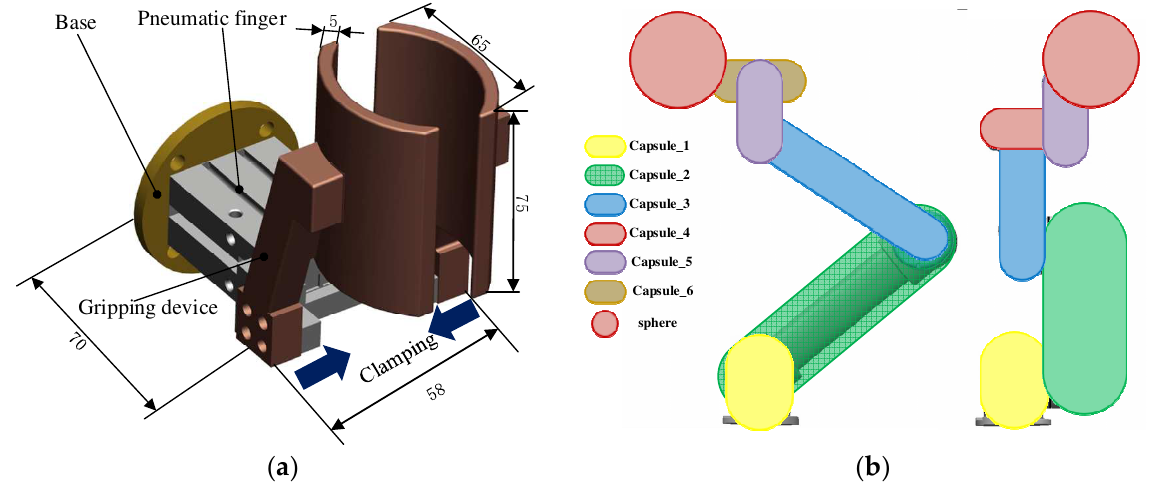
Figure 8. Simplified model of robotic arm. ( a ) Diagram of end-effector structure ( b ) Diagram of robotic arm structure.